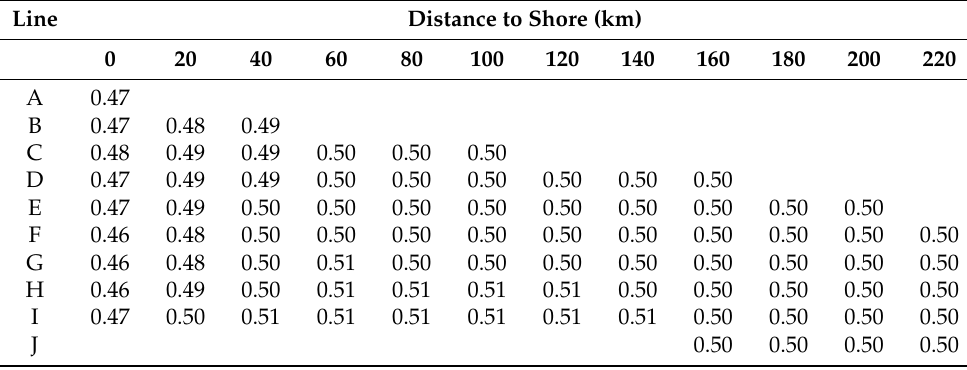
Table 3. Distribution of the COV values indicated for the ERA5 data ( U 100 ), considering the time interval 2000–2019.